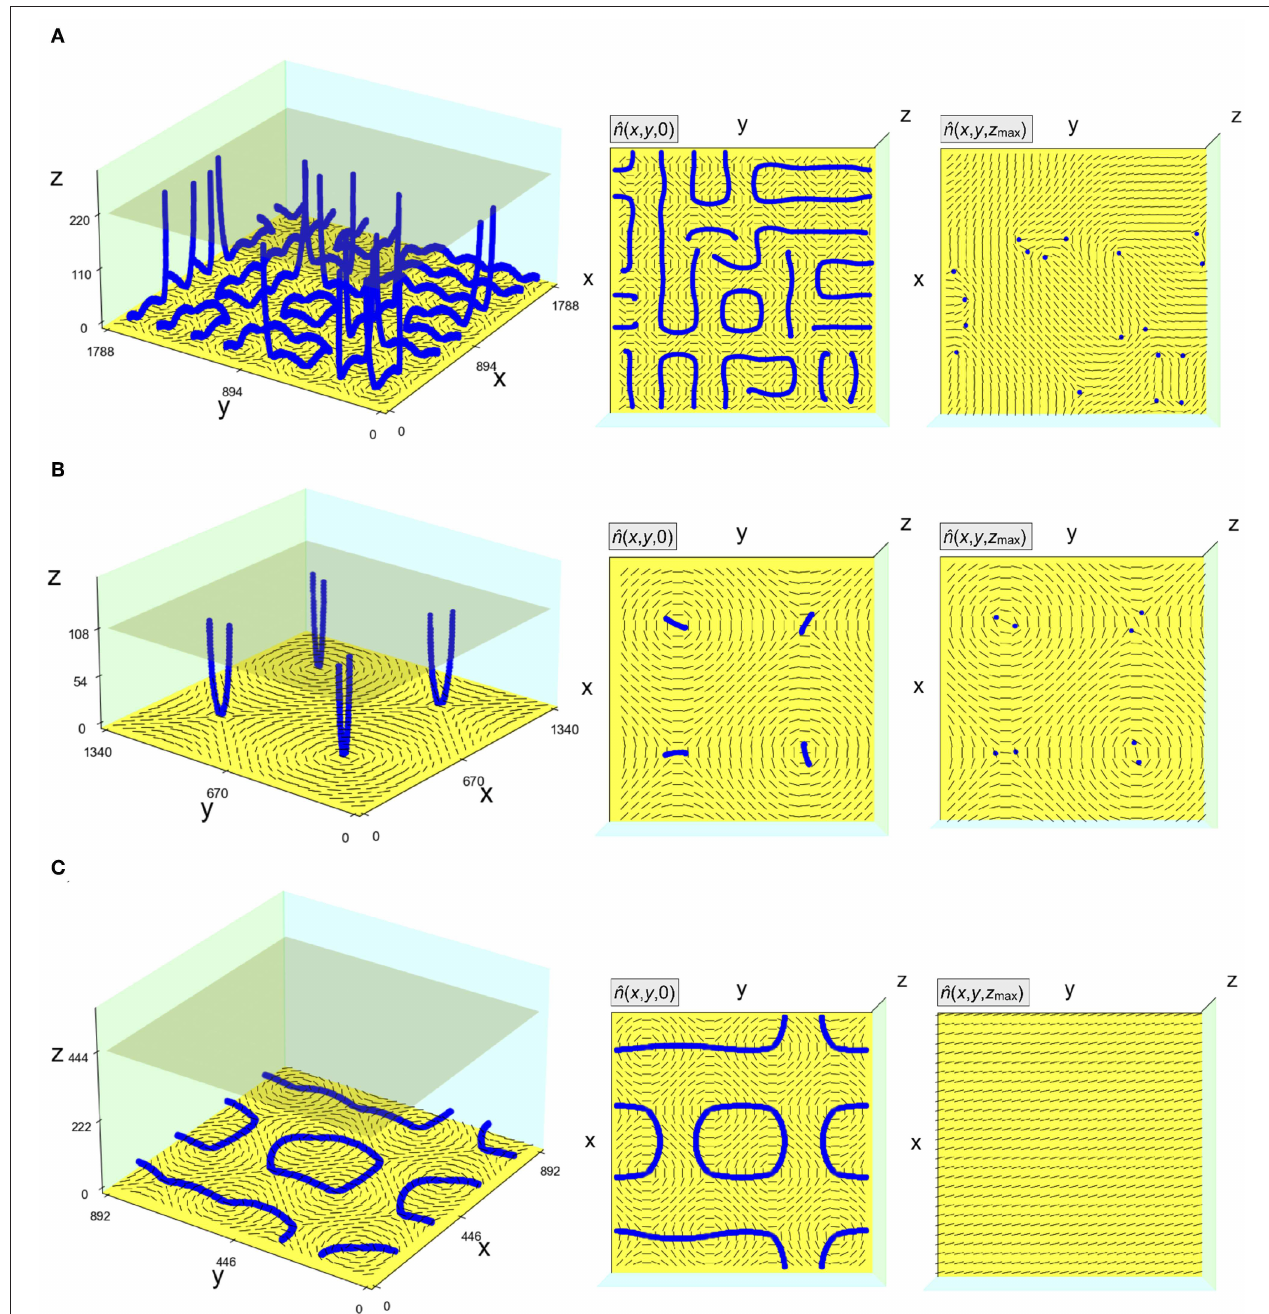
FIGURE 6 | Numerically computed disclination configurations near planar substrates patterned with square arrays of alternating opposite planar boundary (transparent square) has degenerate planar anchoring. (A) An 8 (B) A 2 2 array of surface disclinations with spacing equal to six times the cell thickness. (C) A 4 × thickness. Configurations in (A–C) are partially energy-minimized. Disclinations are colored blue. Axes values are given in units of the lattice spacing. In each row, the second panel shows a top view of the disclinations in bulk and the director field in the plane of the patterned substrate; the third panel shows a top view of the director field on the opposite surface, along with the half-integer disclination points (if any) in that surface. These images were made using the “visualize.py” Python script included in the repository for taking saved configurations and making simple visualizations from the command